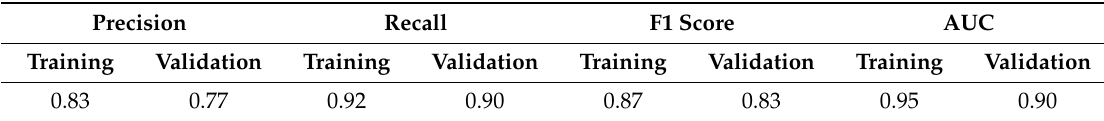
Table 4. The evaluation result of training and